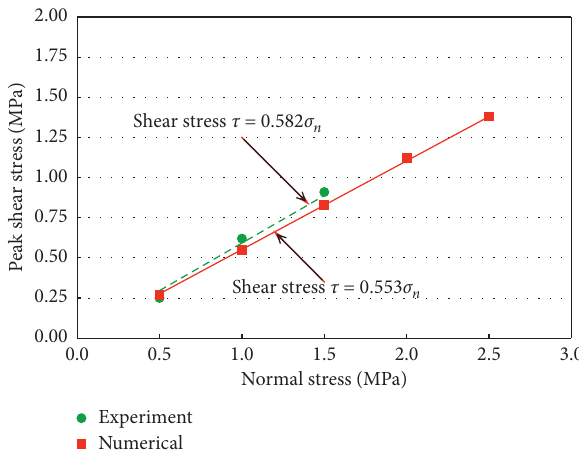
Figure 10: Peak shear strength from numerical and experiment direct shear tests on a sawn planar fracture. Table 4: Microproperties of the